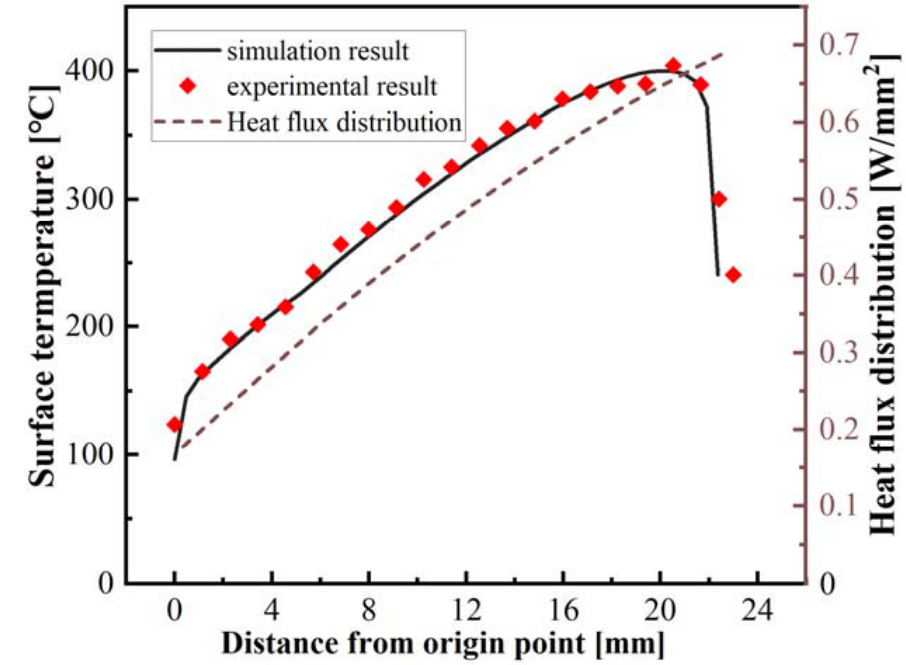
Figure 11. The temperature distribution on the tape surface (comparison of experiment and simulation results).